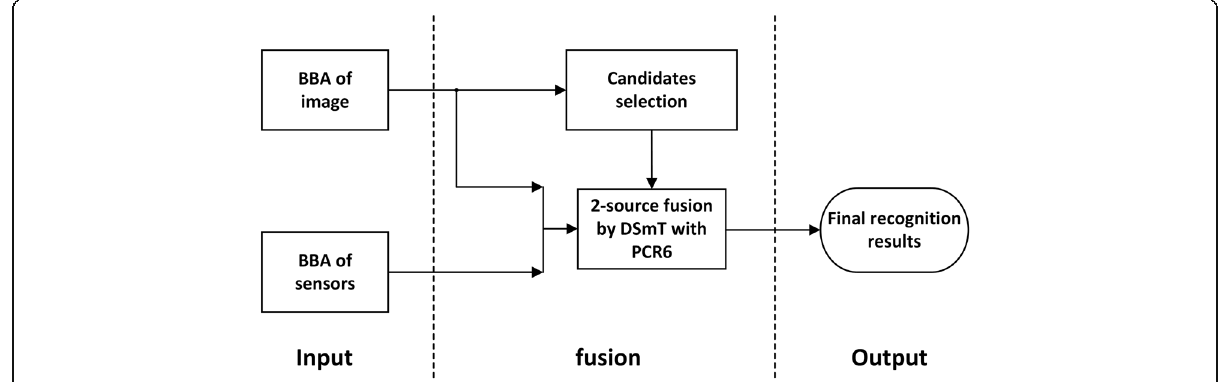
Fig. 9 Architecture of the simplified 2-L HFNDCS